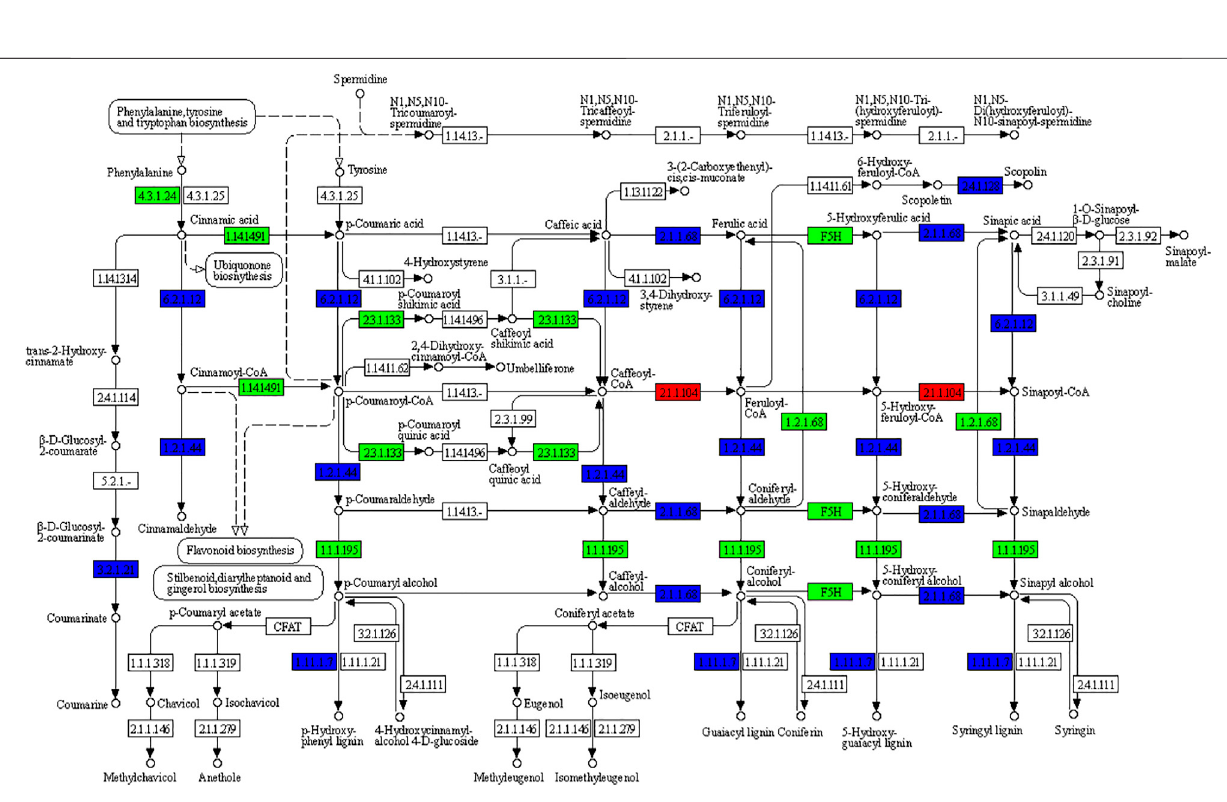
Frontiers in Genetics |